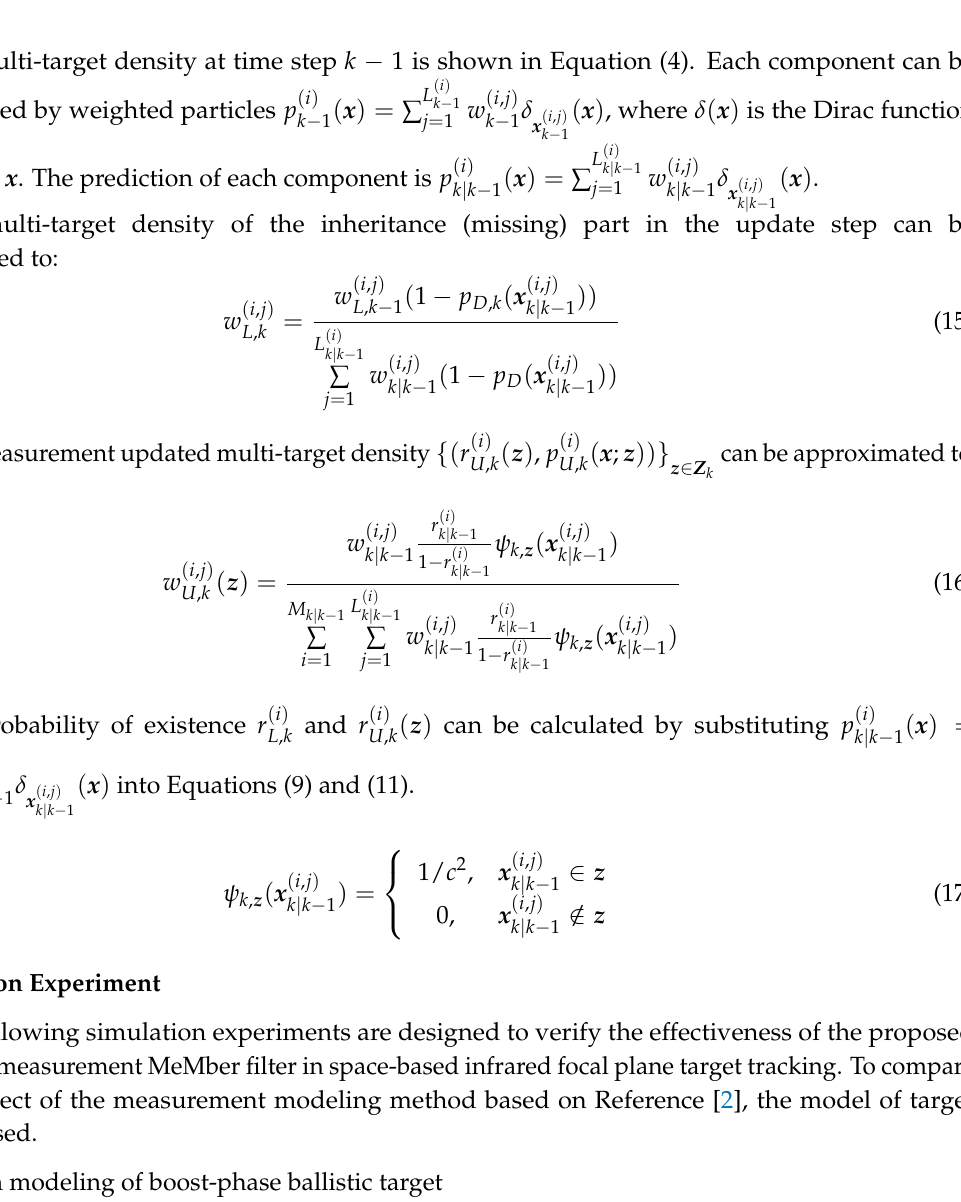
Figure 6. Trajectory in launch coordinate system. (2)